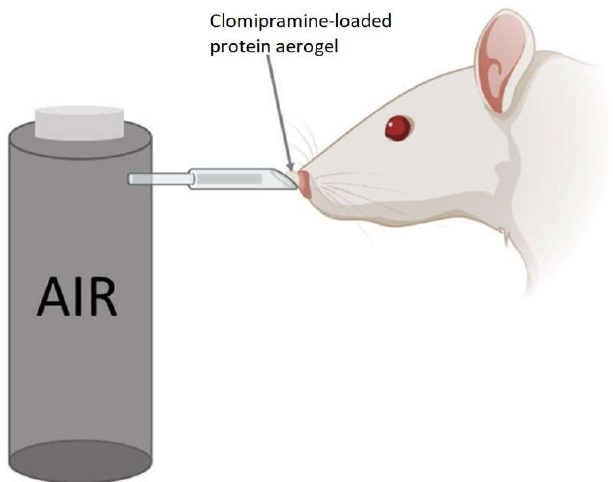
Figure 5. Method of nasal administration of the clomipramine-loaded protein aerogel for rats.